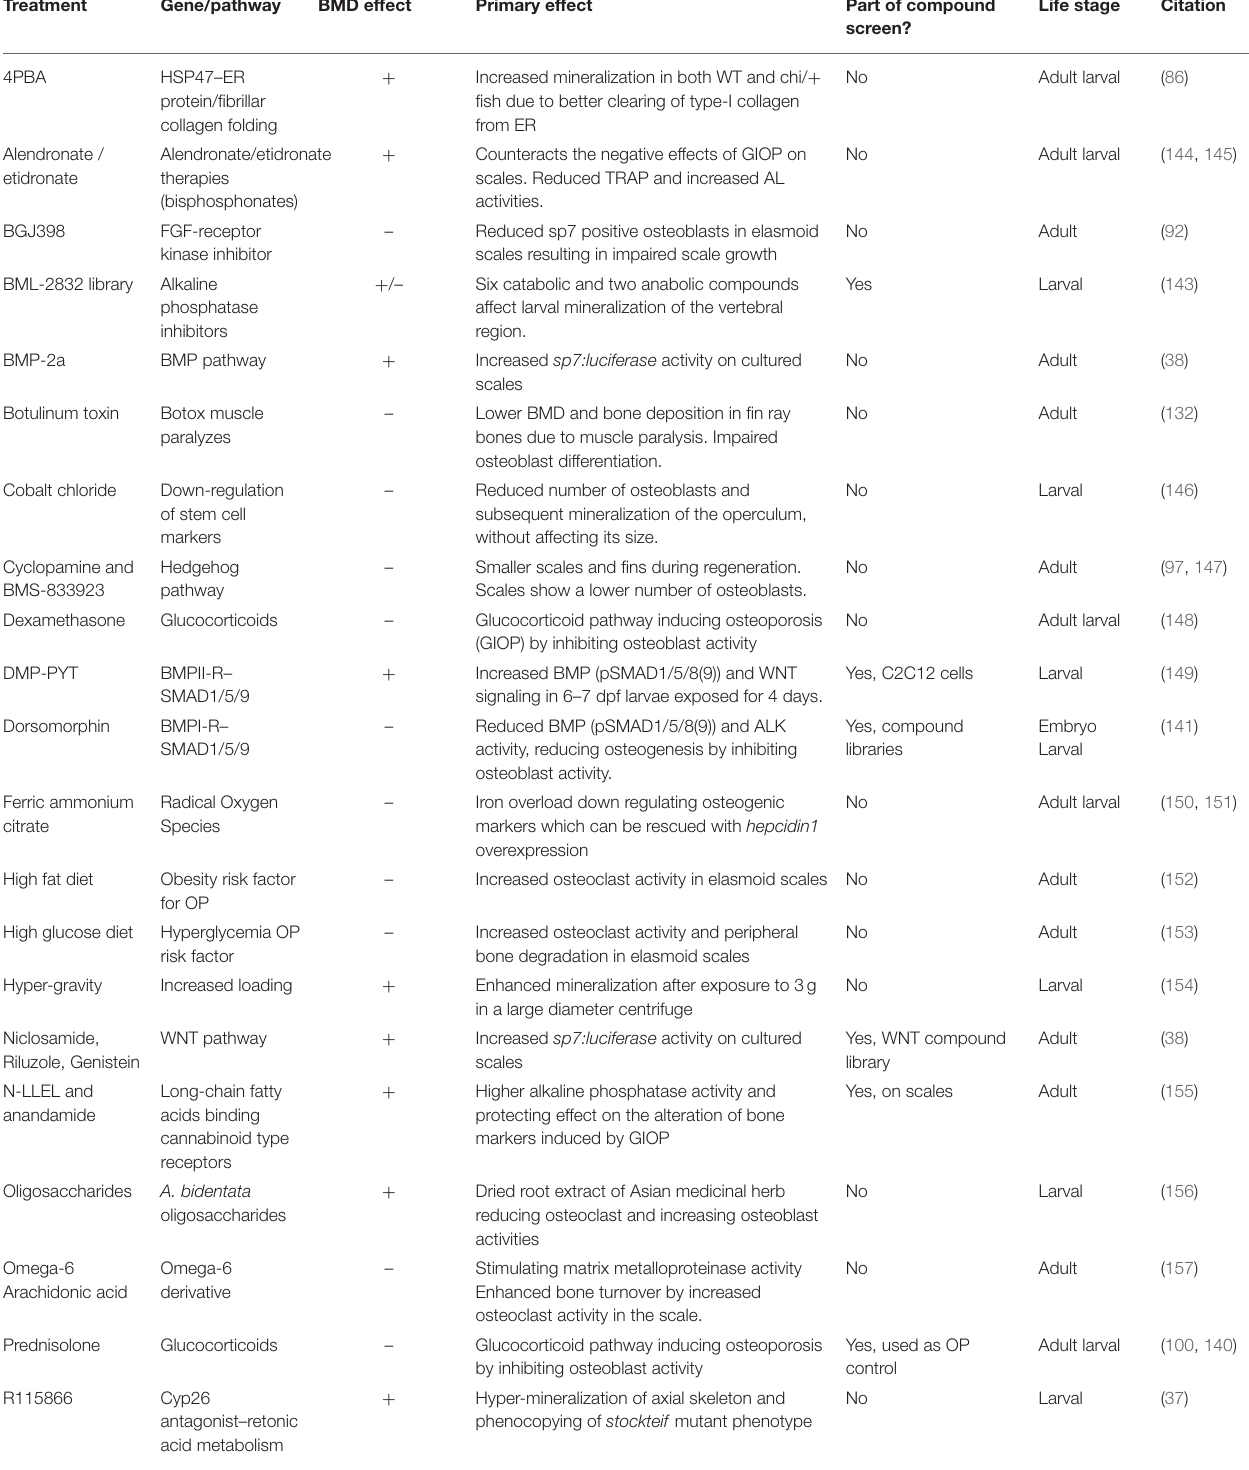
TABLE 3 | List of compounds, diets, and exercise that alter ossification in zebrafish larvae, adults, and/or adult elasmoid scales.